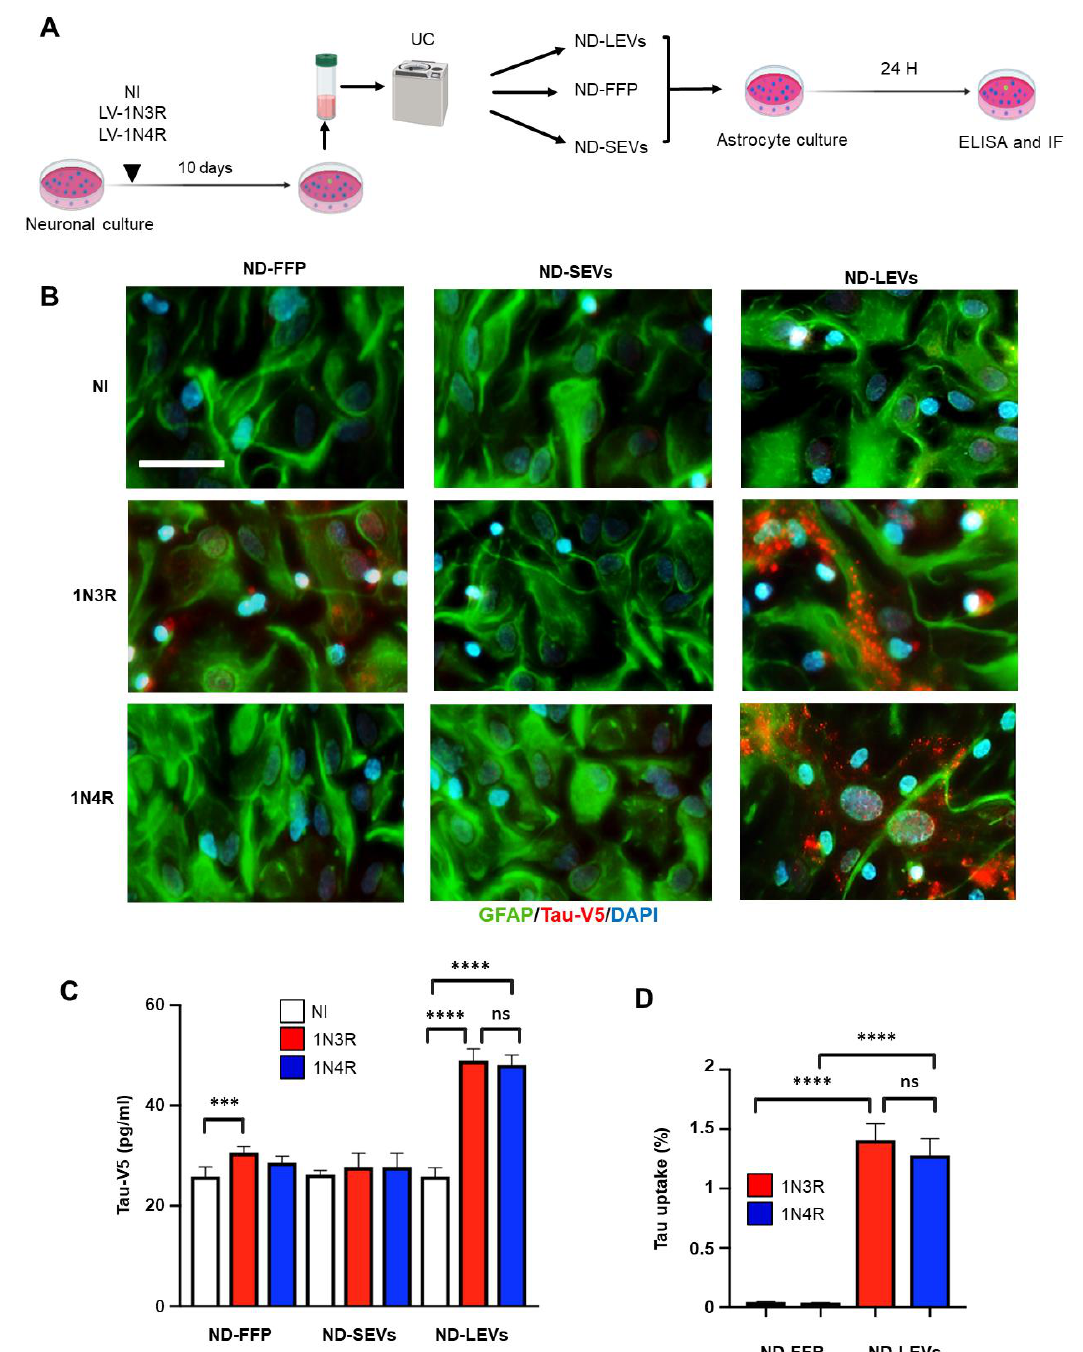
Figure 3. Tau is shuttled from neurons to astrocytes via LEVs. ( A ) Schematic representation of the protocol employed to isolate ND-EVs from neurons infected by LVs overexpressing 1N3R or 1N4R tau. ND-EVs from NI cultures were used as controls. ( B ) Example of confocal images showing the transfer of ND-FFP, or tau in ND-SEVs and ND-LEVs from neurons overexpressing 1N3R or 1N4R tau. The scale bar is 25 µ m. ( C ) Histogram showing the Tau-V5 concentration in astrocytes 24 h after incubation with the ND-FFP, ND-SEV, and ND-LEV fractions from control rat hippocampal neurons (NI) and those overexpressing 1N3R or 1N4R tau. ( D ) Histogram showing the tau uptake efficiency 24 h after incubation with the ND-FFP and ND-LEV fractions from control rat hippocampal neurons (NI) and those overexpressing 1N3R or 1N4R tau. For ( C ) and ( D ), n = 4 cultures per condition; ordinary one-way ANOVA with Sidak’s multiple comparison test. ( ns p > 0.05, *** p < 0.001, **** p <